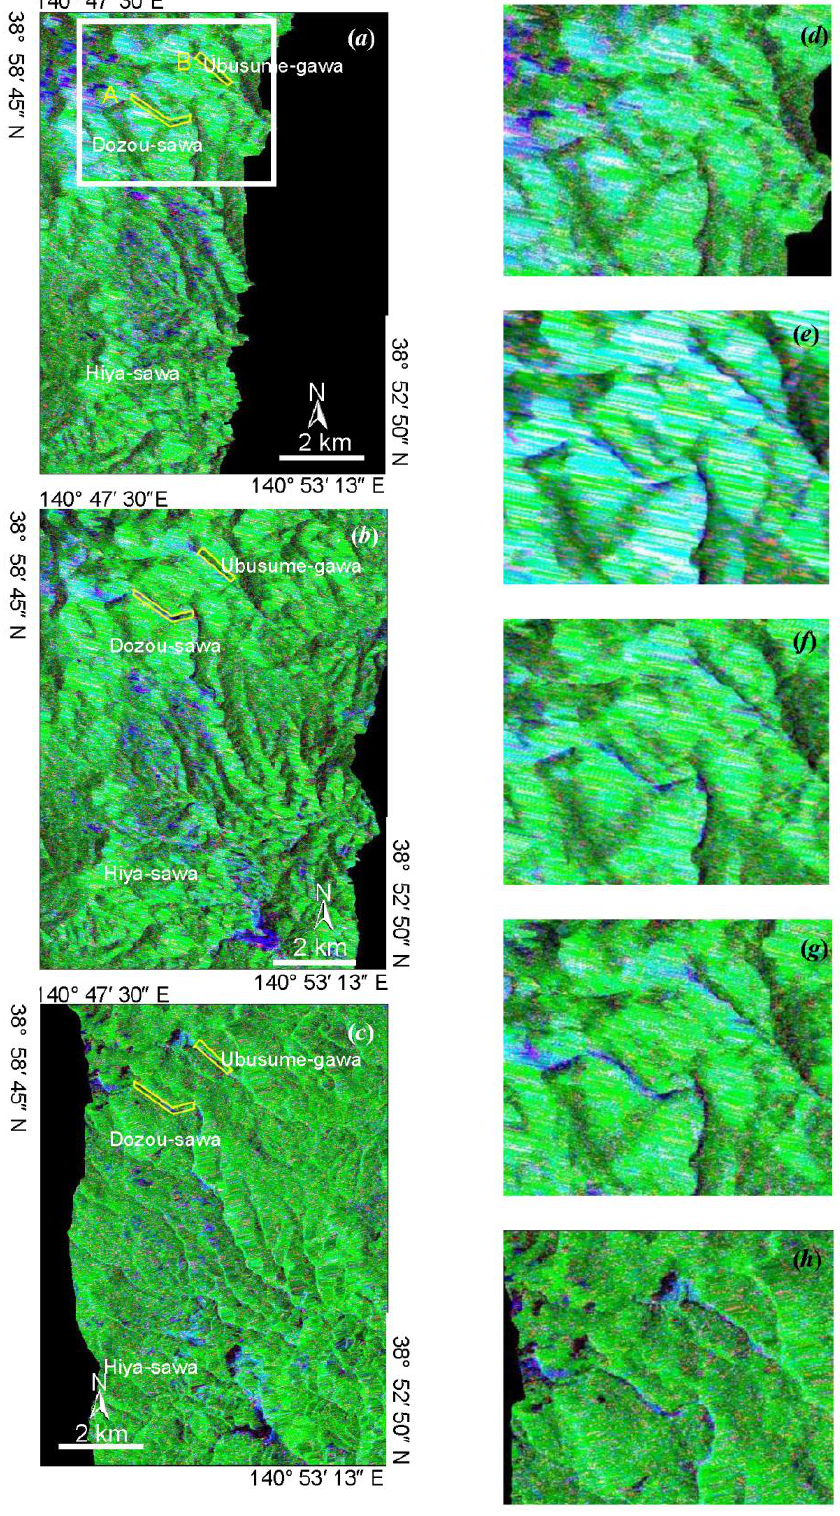
Figure 3. Ortho-rectified Freeman–Durden decomposition images for ( a ) 19 May 2006, ( b ) 24 November 2008, and ( c ) 4 June 2009. White rectangle area with Dozou-sawa and Ubusume-gawa is expanded and shown in ( d ) 19 May 2006, ( e ) 24 August 2008, ( f ) 9 October 2008, ( g ) 24 November 2008, and ( h ) 4 June 2009. The image shows double-bounce scattering as red, volume scattering as green, and surface scattering as